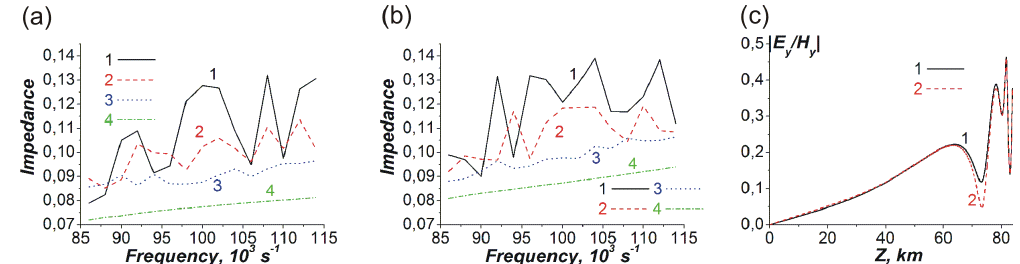
Figure 10. (a, b) Frequency dependencies of the real (a) and imaginary (b) parts of the effective tensor impedance Z 011 component at the upper boundary ( z = L z , see Fig. 1) of the WGEI. Lines 1 (black), 2 (red), 3 (blue) and 4 (green) correspond to θ = 5, 30, 45 and 60 ◦ , respectively. Panel (c) shows the polarization parameter | E y /H y | altitude dependency at the frequency 0 . 86 × 10 5 s − 1 and angle θ = 45 ◦ for the isotropic surface impedance Z 0 at the lower surface of the WGEI equal to 10 − 4 . Earth conductivity σ is equal to 10 9 s − 1 for line 1 and Z 0 = 10 − 2 ( σ = 10 7 s − 1 ) for line 2.